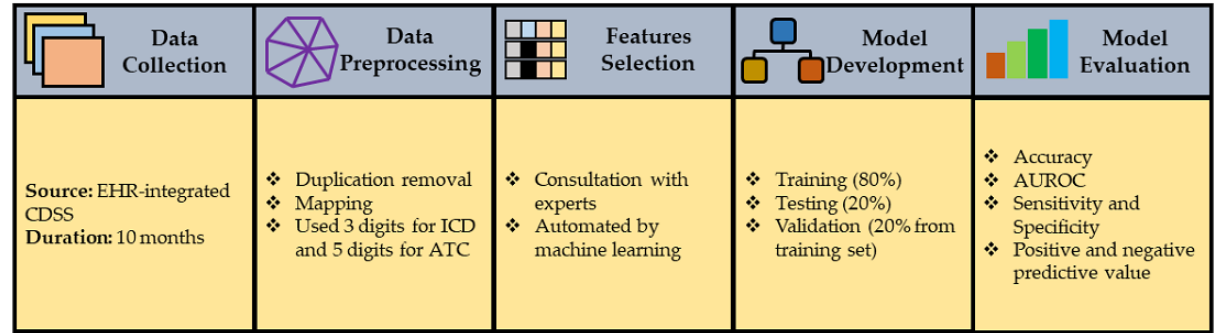
Figure 1. Study design process. ATC: Anatomical Therapeutic Chemical classification system; AUROC: area under the receiver operating characteristic curve; CDSS: clinical decision support system; EHR: electronic health record; ICD: International Classification of